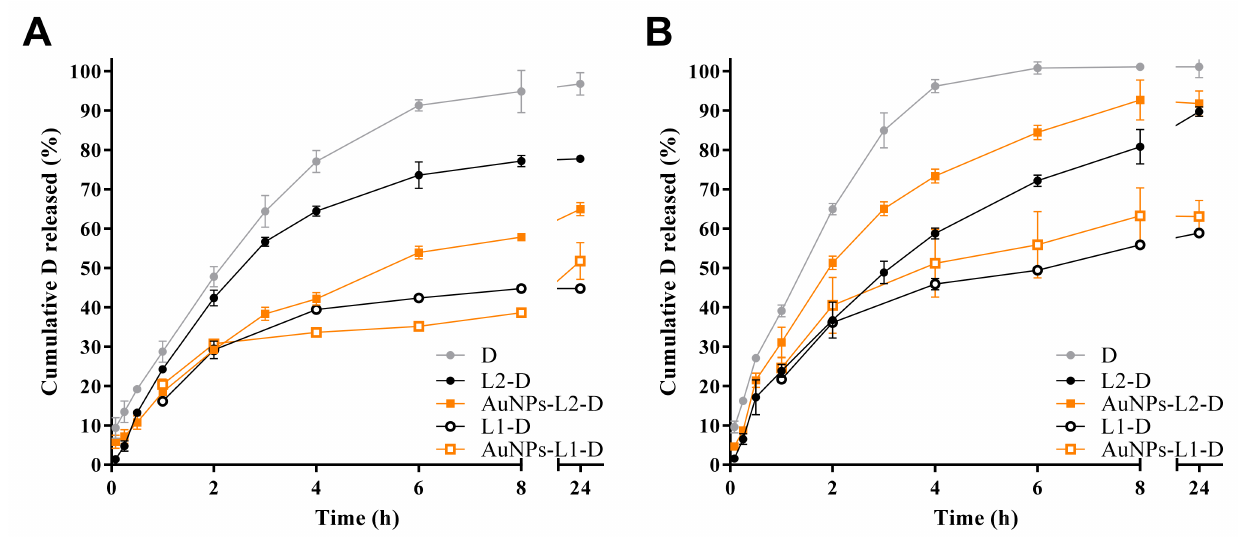
Figure 6. Effects of temperature, ( A ) 37 ◦ C and ( B ) 42 ◦ C, on in vitro release of doxorubicin (D) from both liposomes (L1 and L2, with different proportions of cholesterol, 3.35 mol% and 40 mol%, respectively) and gold nanoparticles (AuNPs)- functionalized liposomes toward Hepes buffer pH 7.4. In vitro D release profiles from the free drug are also